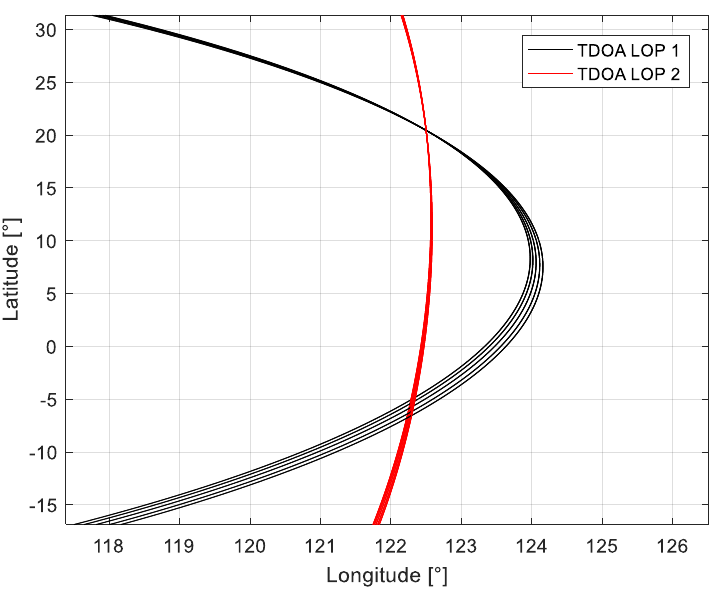
Figure 2. The intersection of the TDOA LOP in multiple moments.